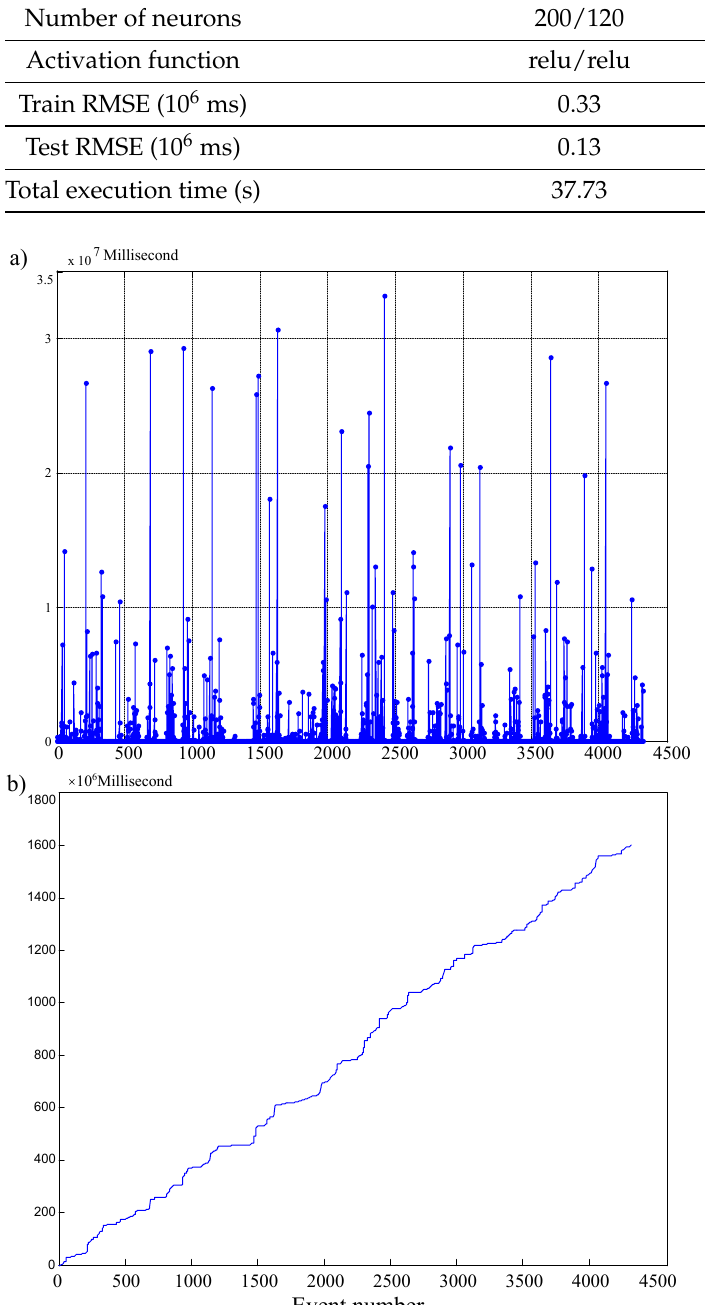
Figure 6. Time representation of the water consumption, ( a ) Time gap between 4321 events (i.e., con- sumed liters) from 02/12/2018 09:11:21.750 until 20/12/2018 23:23:40.625, ( b ) Cumulated duration δ as a function of consumed